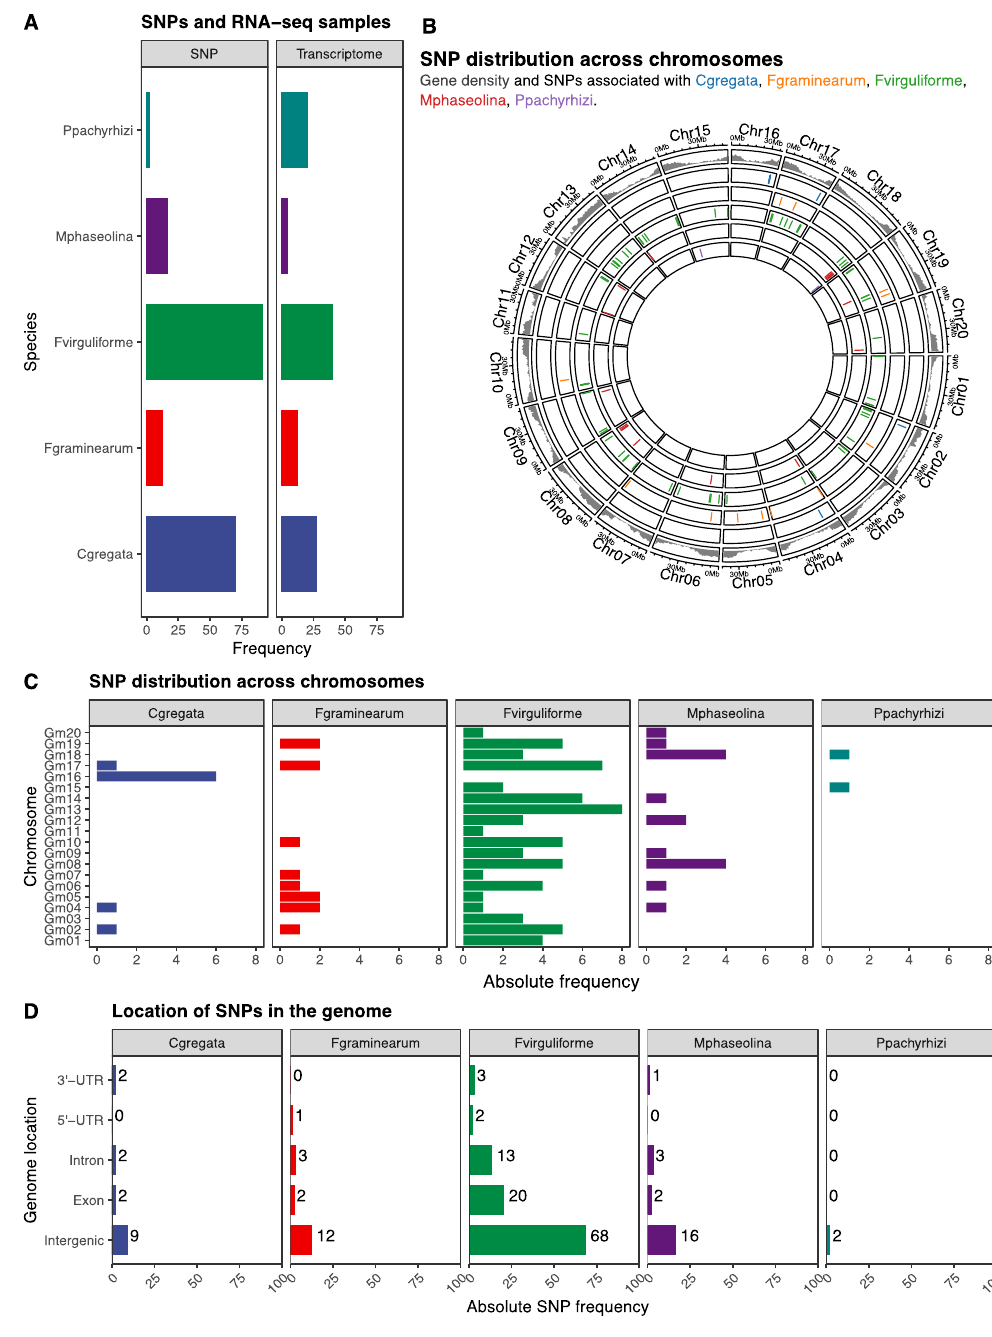
Figure 1. Data summary and genomic distribution of SNPs. ( A ) Frequency of SNPs and RNA-seq samples included in this study. ( B ) Genomic coordinates of resistance SNPs against each fungal pathogen. The outer track represents gene density, whereas inner tracks represent the SNP positions for each species. ( C ) SNP distribution across chromosomes. Overall, there is an uneven distribution of SNPs across chromosomes. ( D ) Genomic location of SNPs. Most SNPs are located in intergenic